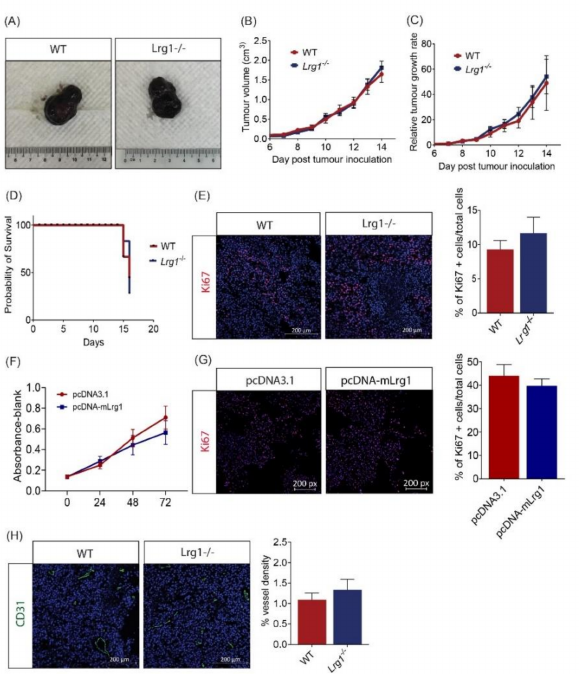
Figure 2. Host Lrg1 -deficiency does not affect tumour growth in a tumour xenograft model. ( A ) Rep- resentative images of B16F10 tumours dissected from wild-type and Lrg1 - / - mice. ( B ) Tumour volume was plotted over time in both experimental groups. ( C ) Tumour growth rates were determined based on changes in tumour volume over time in both experimental groups. ( D ) Kaplan–Meier survival curves of wild-type or Lrg1 - / - tumour-bearing mice. ( E ) Representative images (left) and quantifica- tion (right) of the percentage of Ki67+ cells (red) in tumour samples collected from wild-type and Lrg1 - / - mice. Nuclei were labelled with DAPI (blue). ( F ) MTS assay was performed on B16F10 cells transfected with pcDNA-mLrg1 or pcDNA3.1 control plasmid at 24, 48, and 72 h post-transfection. ( G ) Representative images (left) and quantification (right) of Ki67+ cells (red) in Lrg1 overexpress- ing or pcDNA3.1 plasmid transfected control B16F10 cells. ( H ) Representative images (left) and quantification (right) of CD31+ vessel (Green) in tumour samples collected from wild-type or Lrg1 - / - mice. All images are representative. Data are presented as the mean ± SEM. of three independent experiments. Statistical analysis was performed via two-tailed, unpaired Student’s t